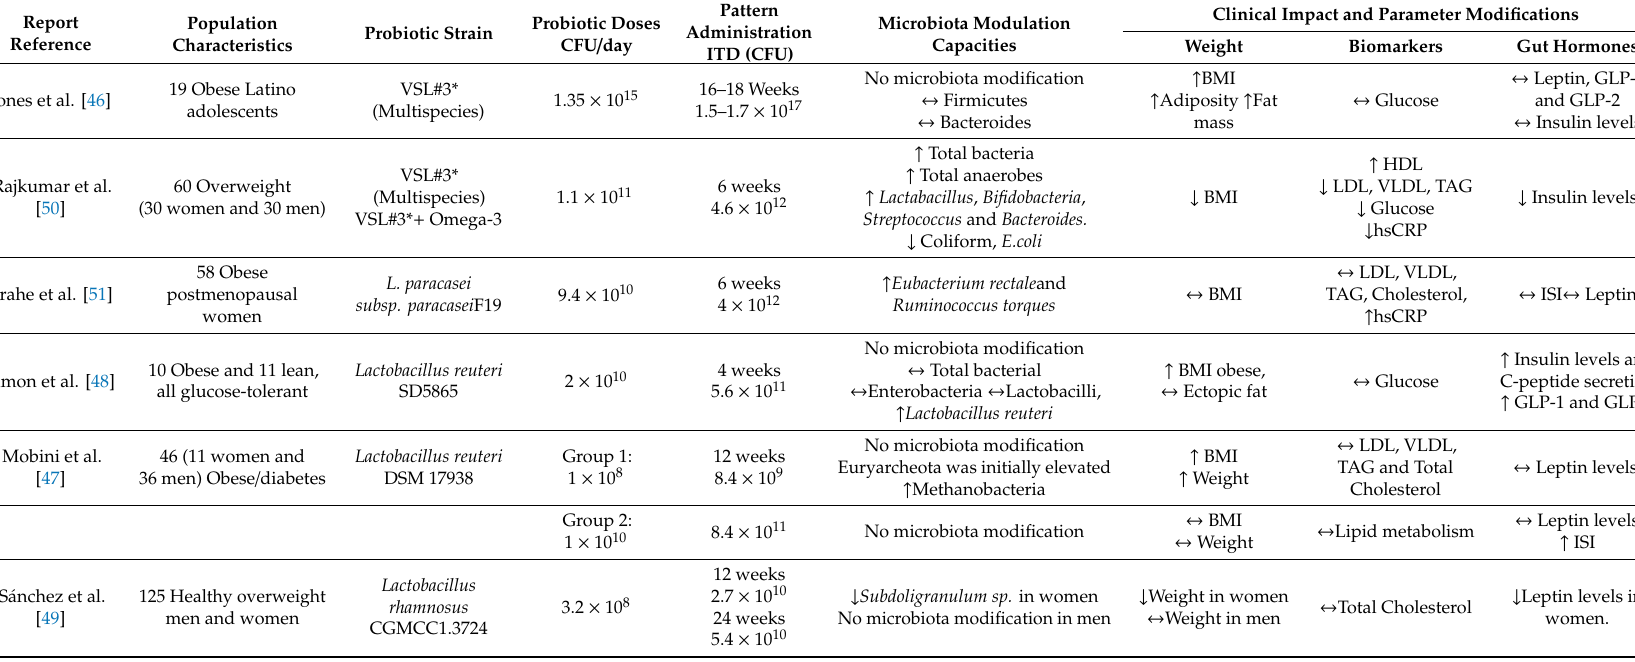
Table 1. Summary of the probiotic strain’s e ff ects in obesity and related metabolic disorders from selected clinical